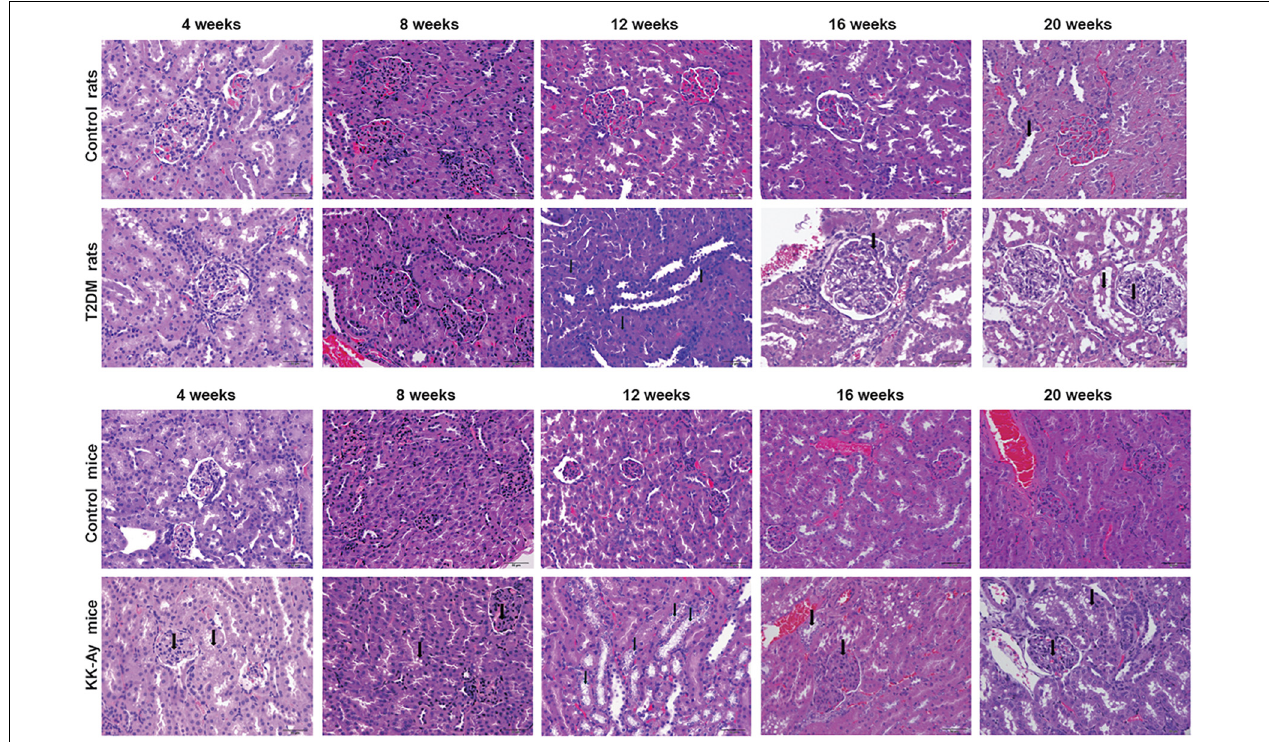
FIGURE 5 | Comparisons on the pathological changes of kidney in T2DM rats and KK-Ay mice. Representative H&E images show the pathological changes of kidneys from control/T2DM rats and control/KK-Ay mice at the indicated time points after the initial of modeling. Magnification, 40 ×